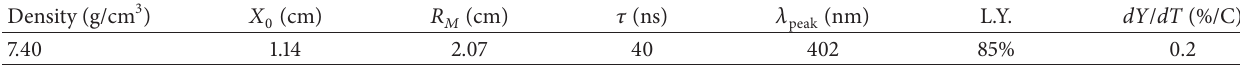
Table 2: Main parameters of the LYSO (Ce)